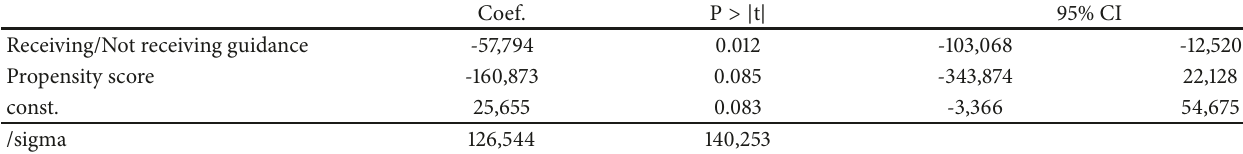
Table 5: Results of the Tobit regression with metabolic-related medical expenses set as an objective variable. Coef. P > | t |